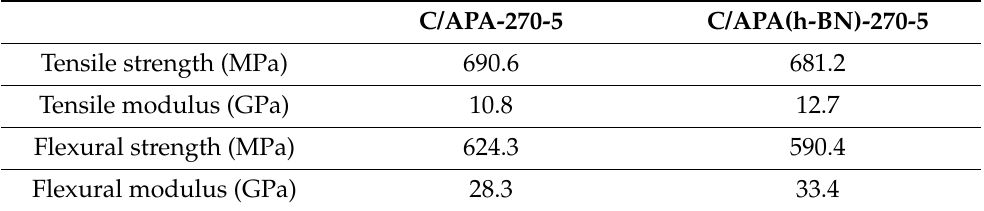
Table 3. Mechanical properties of Carbon/APA composites according to the inclusion of h-BN (10